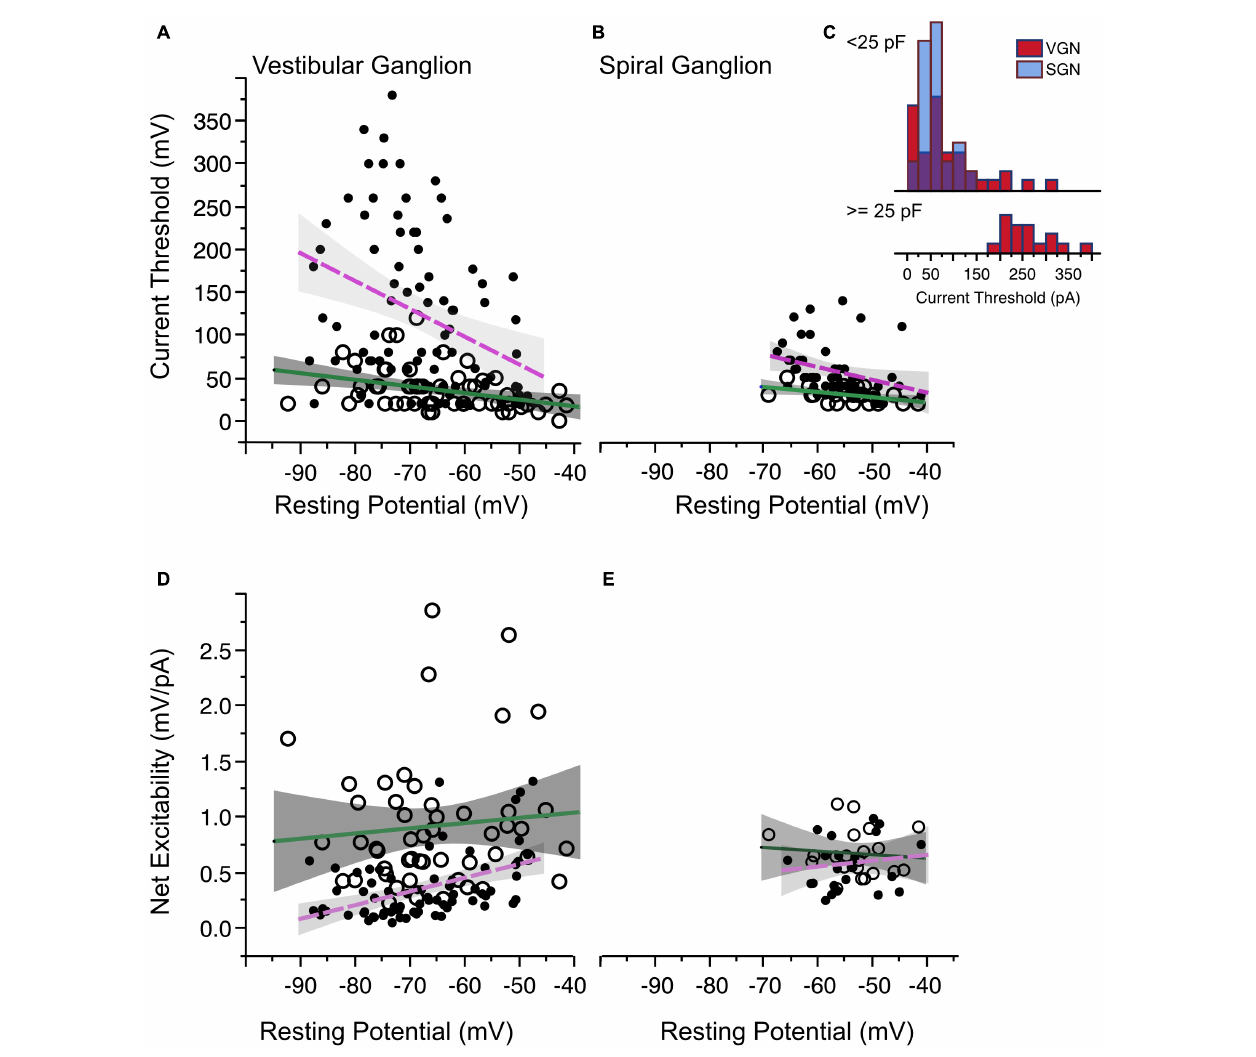
FIGURE 5 | Current threshold and net excitability. (A) Current threshold as a function of resting potential in vestibular ganglion neurons. Sustained-spiking neurons are drawn with open circles, transient-spiking neurons are drawn with small solid circles. Lines with gray shading show linear regressions with 95% confidence intervals (dashed magenta line for transient-firing and solid green line for sustained-firing). (B) Current threshold vs. resting potential for spiral ganglion neurons. Symbols and regression lines as in (A) . (C) Histogram of current thresholds in transient spiking neurons. The top histogram is for small to medium-sized cells with capacitance values less than 25 pF. All SGN are assumed to belong to this group. The bottom histogram is for large-sized cells with capacitance values greater than 25 pF. Current thresholds are larger for these cells than for the rest of the SGN and VGN combined. Blue bars indicate SGN and red bars indicate VGN. (D,E) The ratio between voltage and current threshold (net excitability) is plotted against resting potential for VGN and